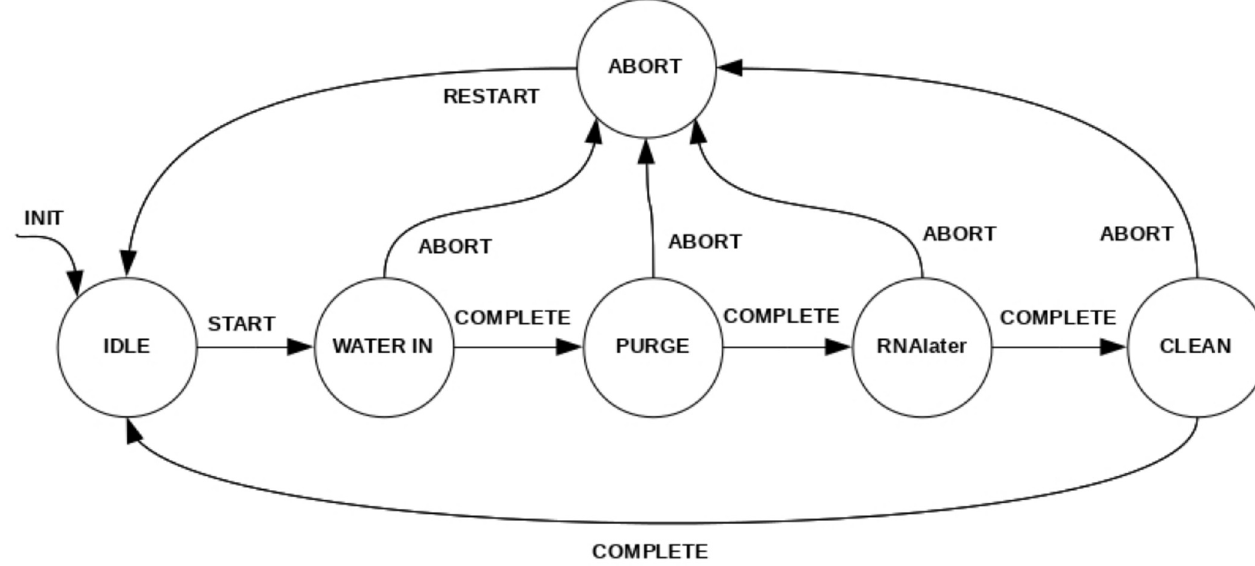
Fig 5. Embedded control software state machine. State machine implemented in the microcontroller firmware for global control of the system. The flags START COMPLETE and ABORT are set with information from the tasks that are processing the sensors signal.